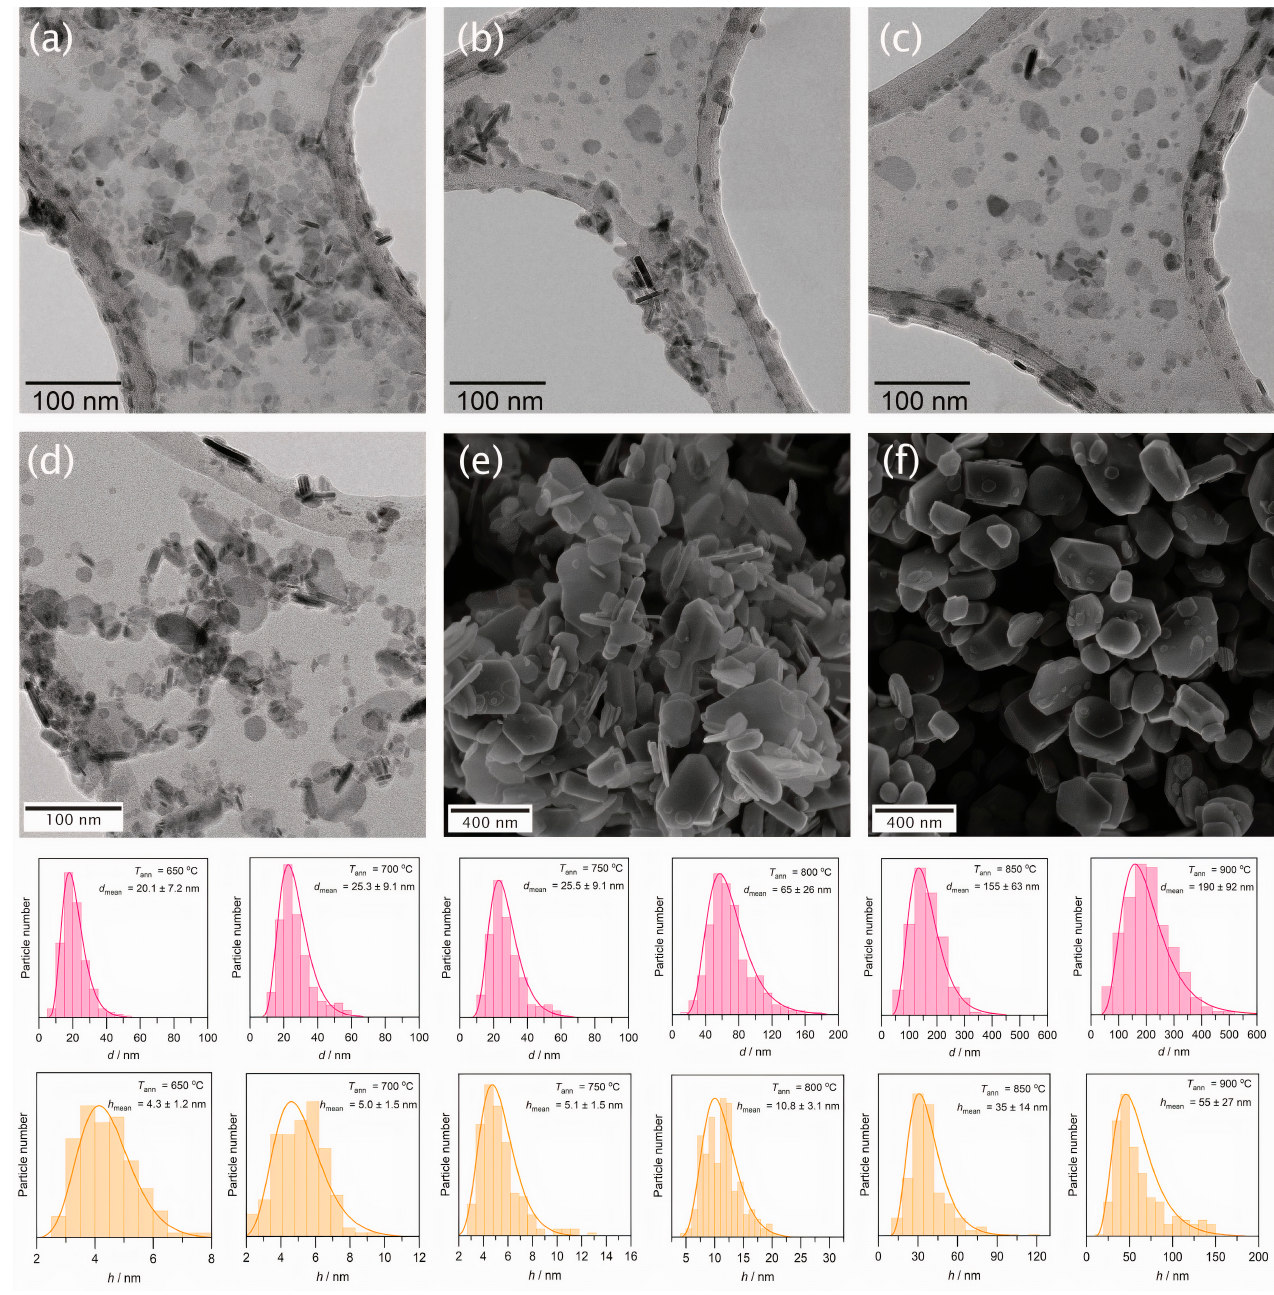
Figure 3. Electron microscopy images of the extracted hexaferrite powders obtained at different annealing temperatures: ( a ) 650 °C; ( b ) 700 °C; ( c ) 750 °C; ( d ) 800 °C; ( e ) 850 °C; ( f ) 900 °C. The corresponding size distributions are shown below.